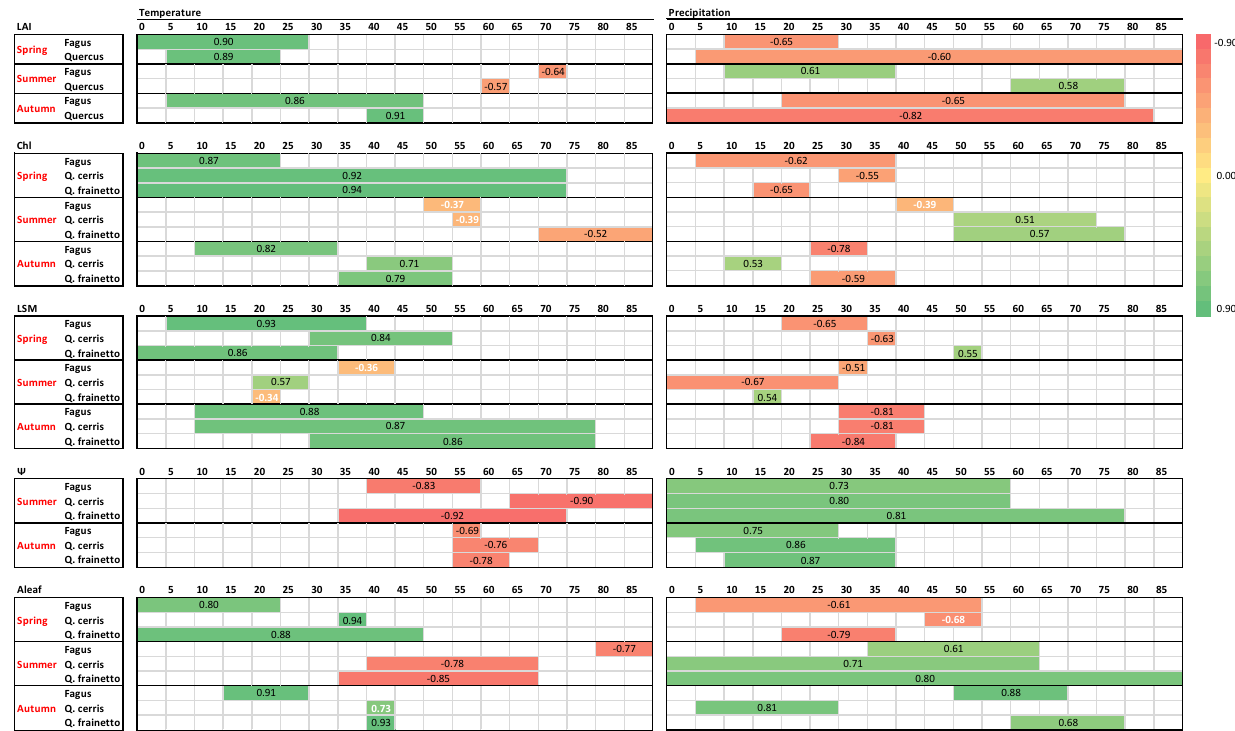
Figure 8. Climatic control on ecophysiological parameters of the three studied species as derived by single linear regressions. For each parameter per species and season, the regression coefficients (R) of the most significant relationships with temperature and precipitation and the corresponding time period are presented in the colored horizontal lines, according to the chromatic scale appearing in the right. Each small box (grey lined) corresponds to a 5-day period and the number of days before measurements are indicated on top of each big box (black lined). Regression coefficients with black color correspond to p < 0.05 and white ones to p > 0.05.